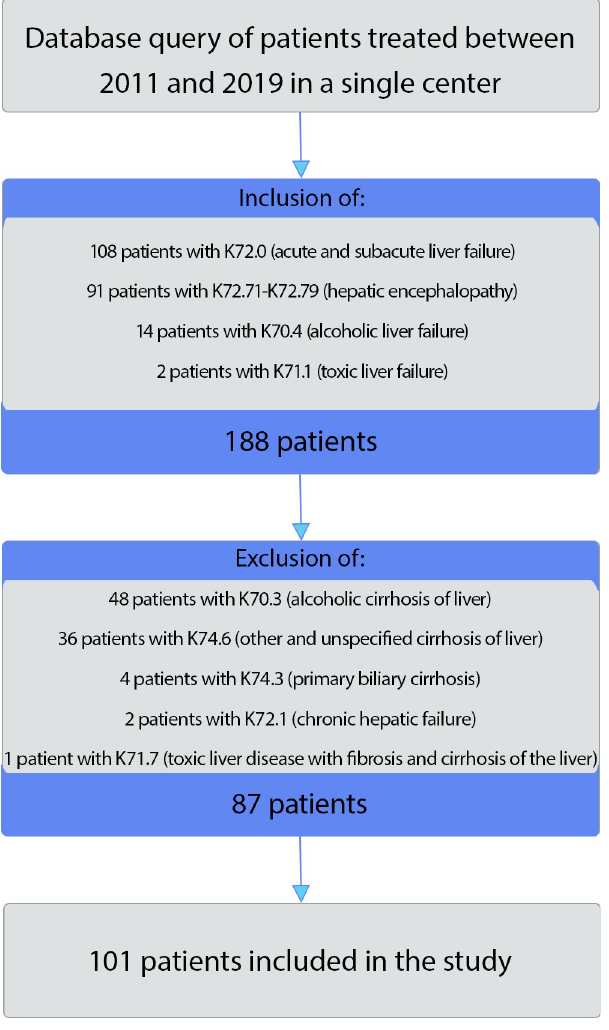
Fig 1. Inclusion and exclusion criteria. 188 patients with acute liver failure were identified in a database query of patients in whose treatment our department at the RWTH Aachen University Hospital has been directly involved between 2011 and 2019. The flowchart illustrates the inclusion and exclusion criteria for further statistical